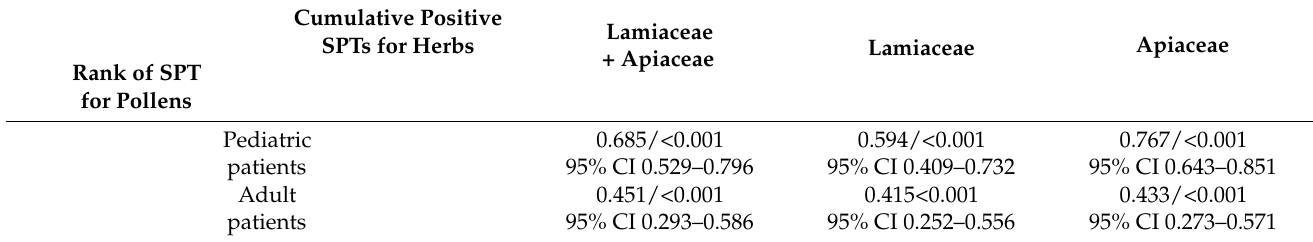
Table 3. Correlations between SPT results for herbs and SPT results for birch, grass or mugwort pollen extracts in pediatric and adult patients (r/ p